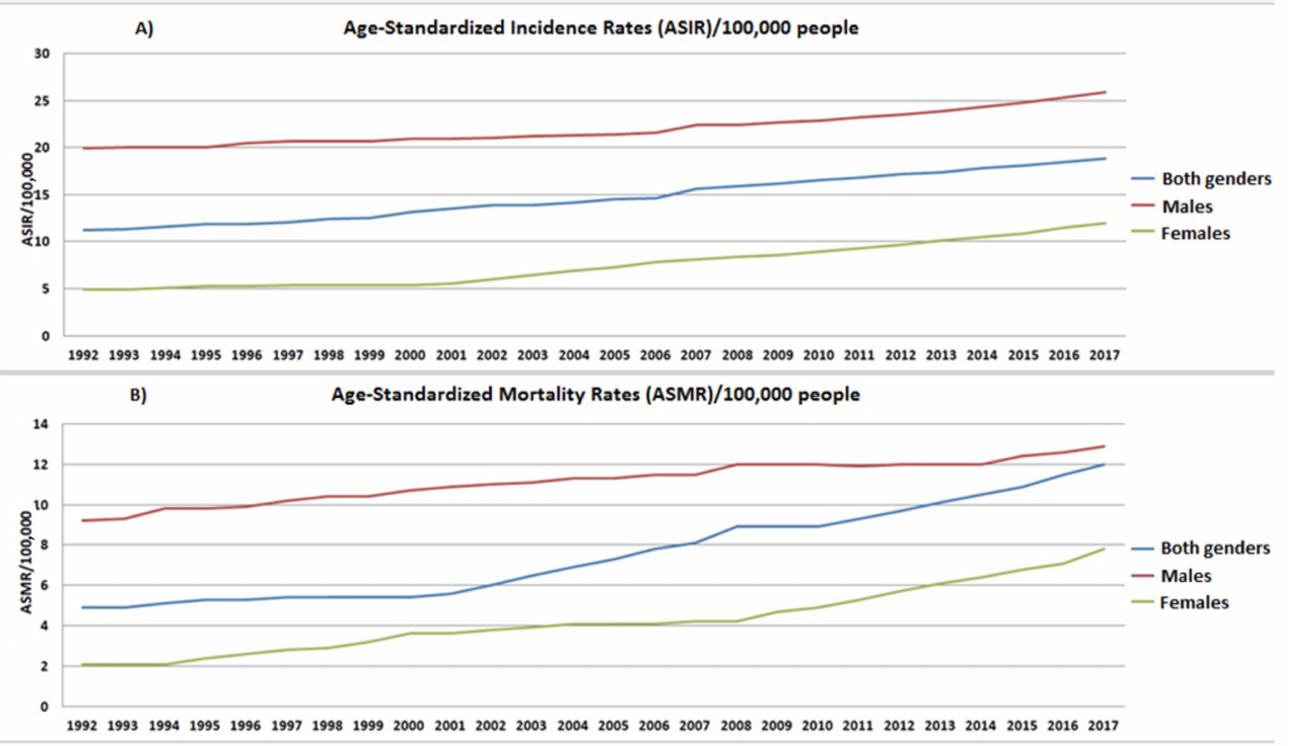
Figure 2. Gender-based distribution of Age-Standardized Incidence ( A ) and Mortality ( B ) Rates per 100,000 people/year for the time period of